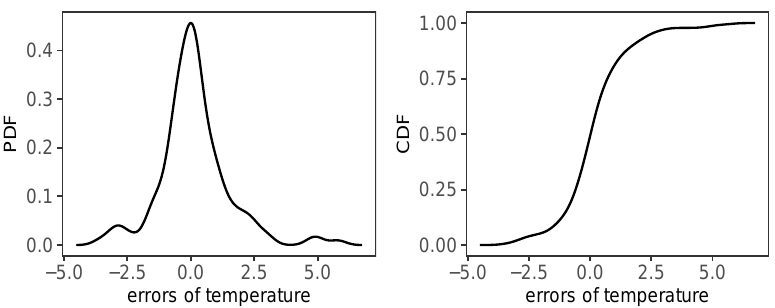
Figure 24. Kernel smoothed empirical PDF ( left ) and CDF ( right ) of errors of temperature by the difference of balloon data and estimates by Kriging.